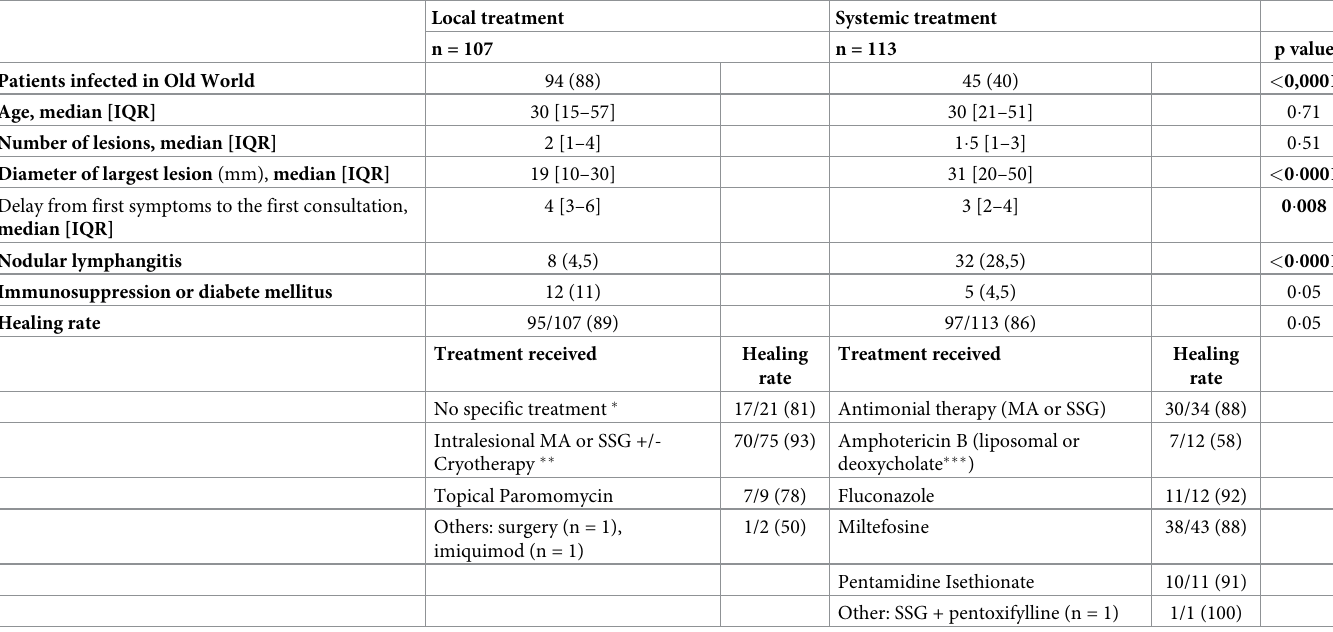
Table 4. Clinical characteristics of patients and healing rates according to treatment administration modality (systemic versus local). Local